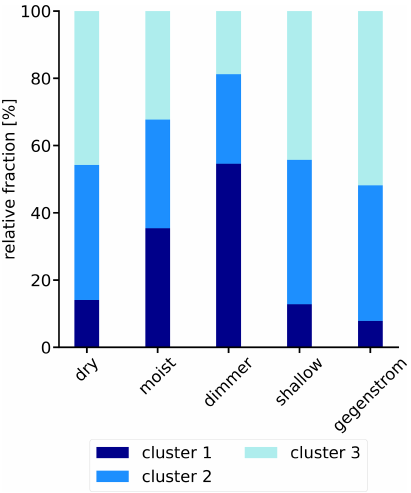
Figure 10. Relative contributions of the different trajectory clus- ters to the overall trajectory sample for the different foehn